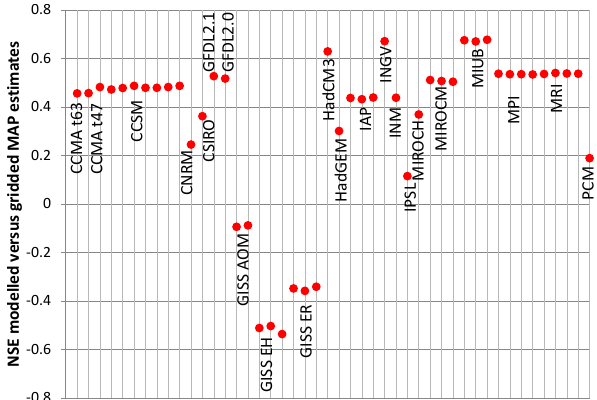
Figure 5. Comparison of MIUB(3) model estimates of mean annual temperature with CRU estimates. (Based on untransformed temper- ature NSE = 0.958, rank 33 of 46 runs, and R 2 = 0 .